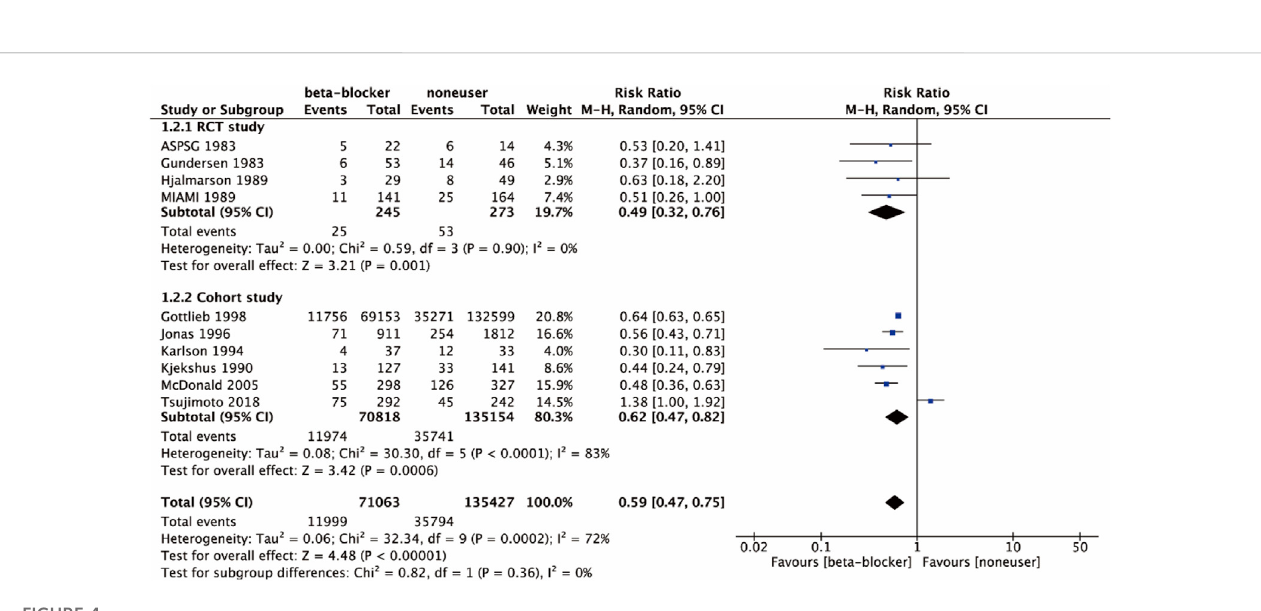
All-cause mortality of the included studies in study